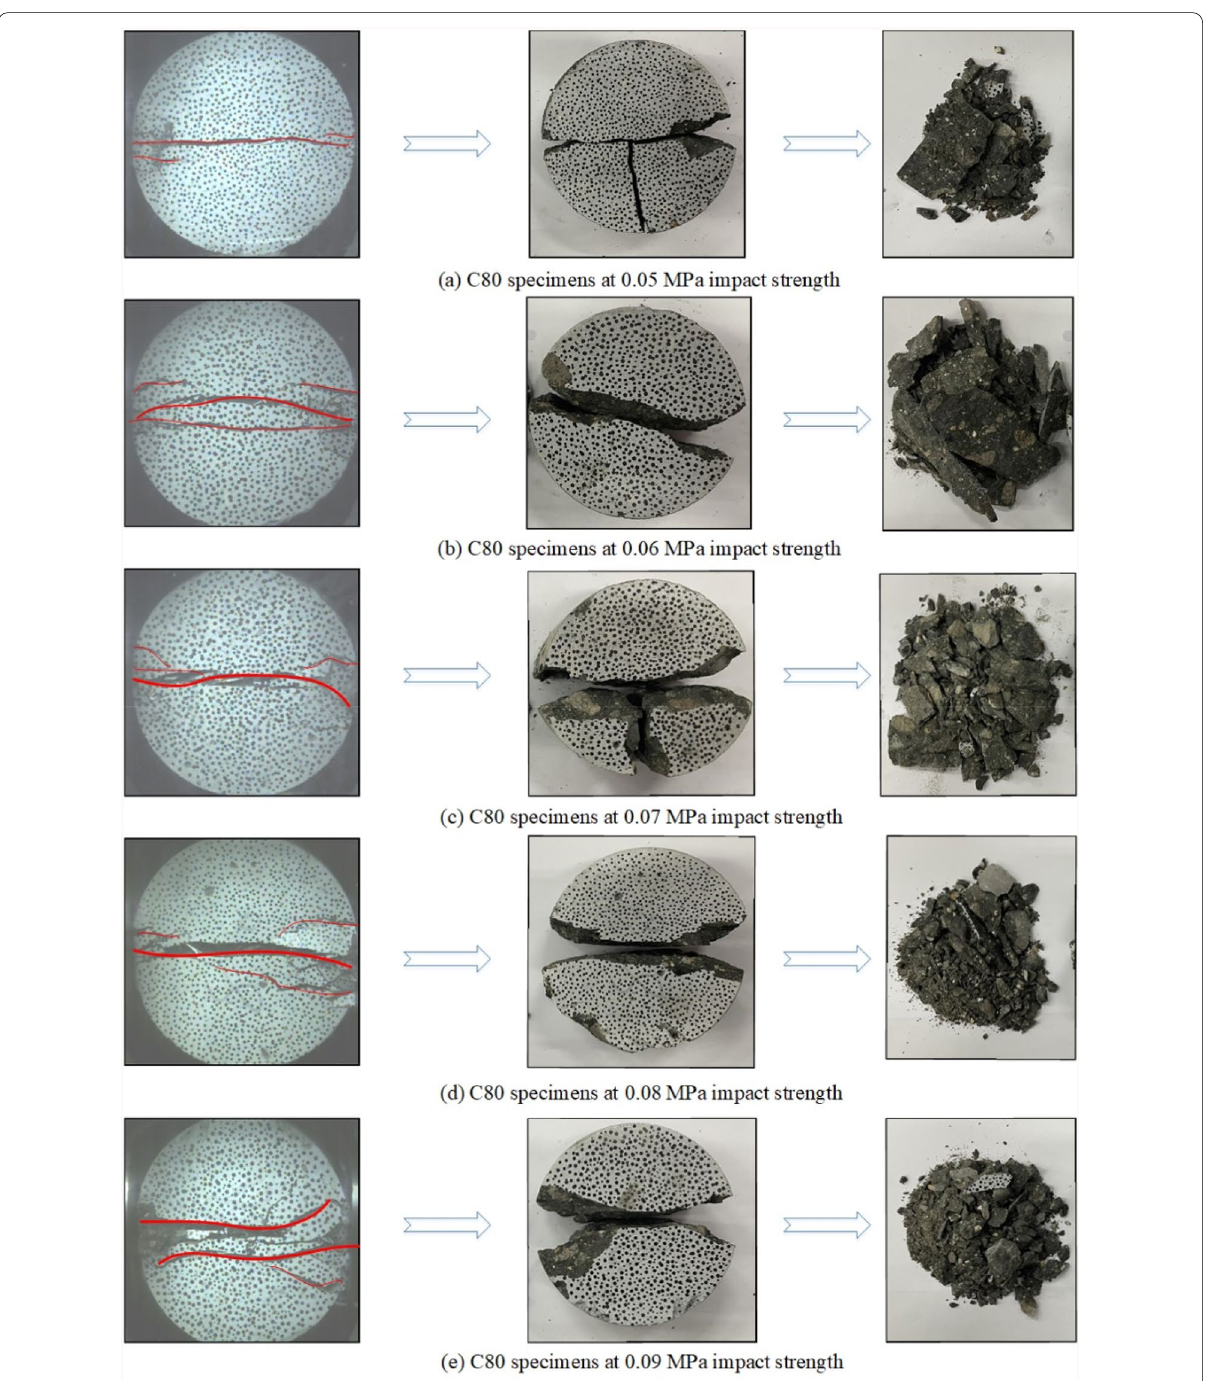
Fig. 5 Damage patterns of C80 concrete specimens at different impact